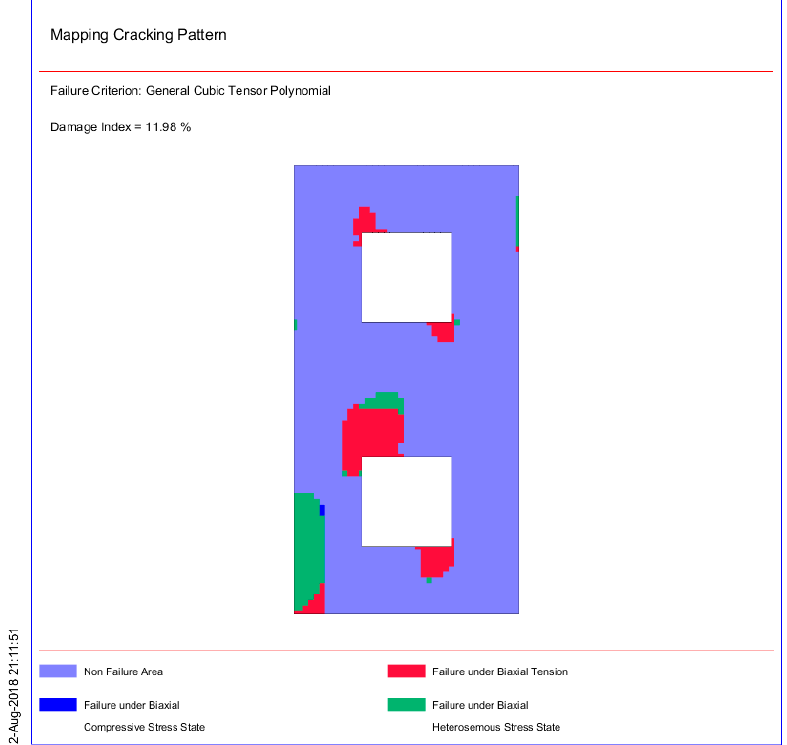
Figure 29. Mapping cracking pattern based on general cubic tensor polynomial failure criterion.